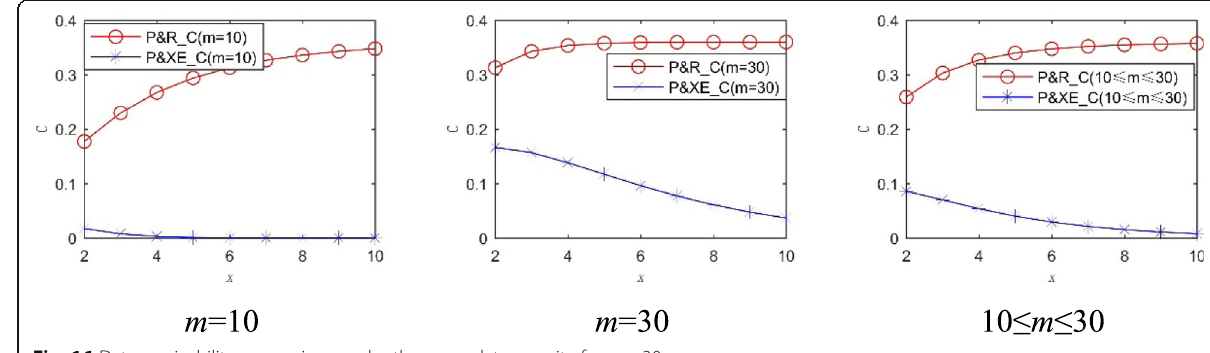
Fig. 16 Data survivability comparison under the same data security for n = 30